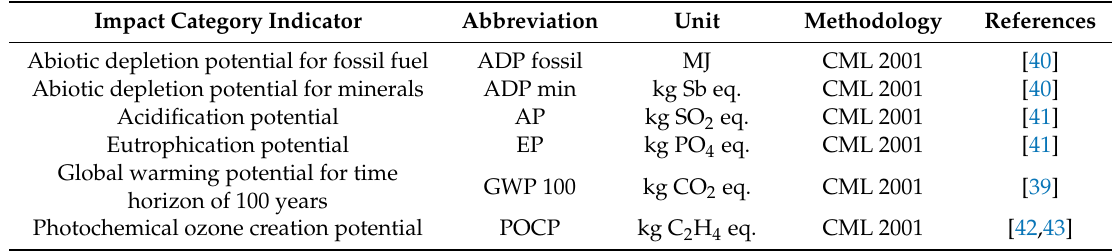
Table 5. Selected impact category indicators for the Life Cycle Impact Assessment